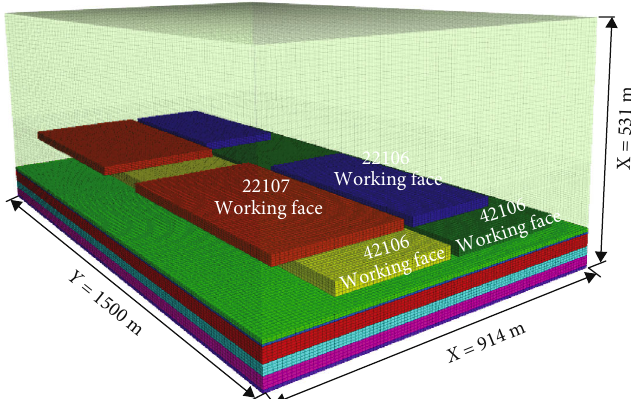
Figure 5: Numerical model of thick hard roof and residual coal pillar